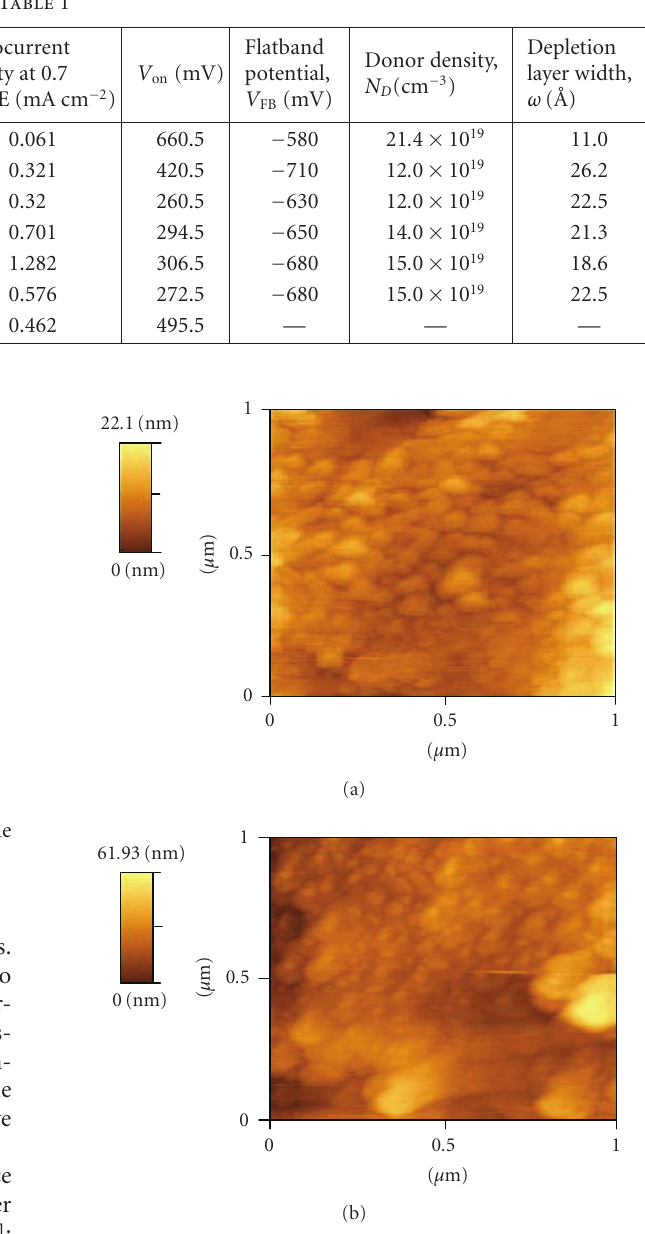
Figure 3: AFM images for the Zn dot deposited on 1.5 at.% Zn- depod hematite, (sample E): (a) hematite film without dots and (b) area of Zn